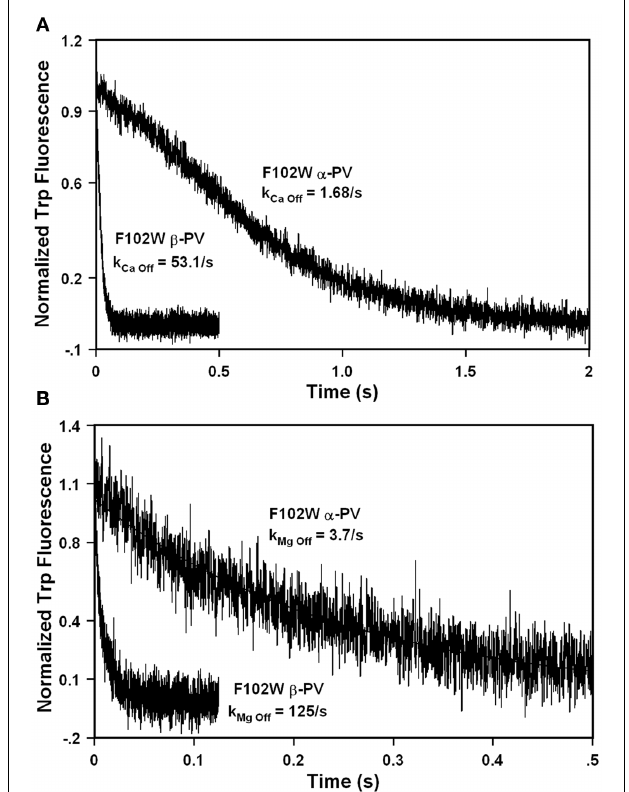
Values marked with * are significantly different from the F102 α -PV values, whereasvaluesmarkedwith # aresignificantlydifferentfromtheF102 β -PVvalues (P < 0.05).